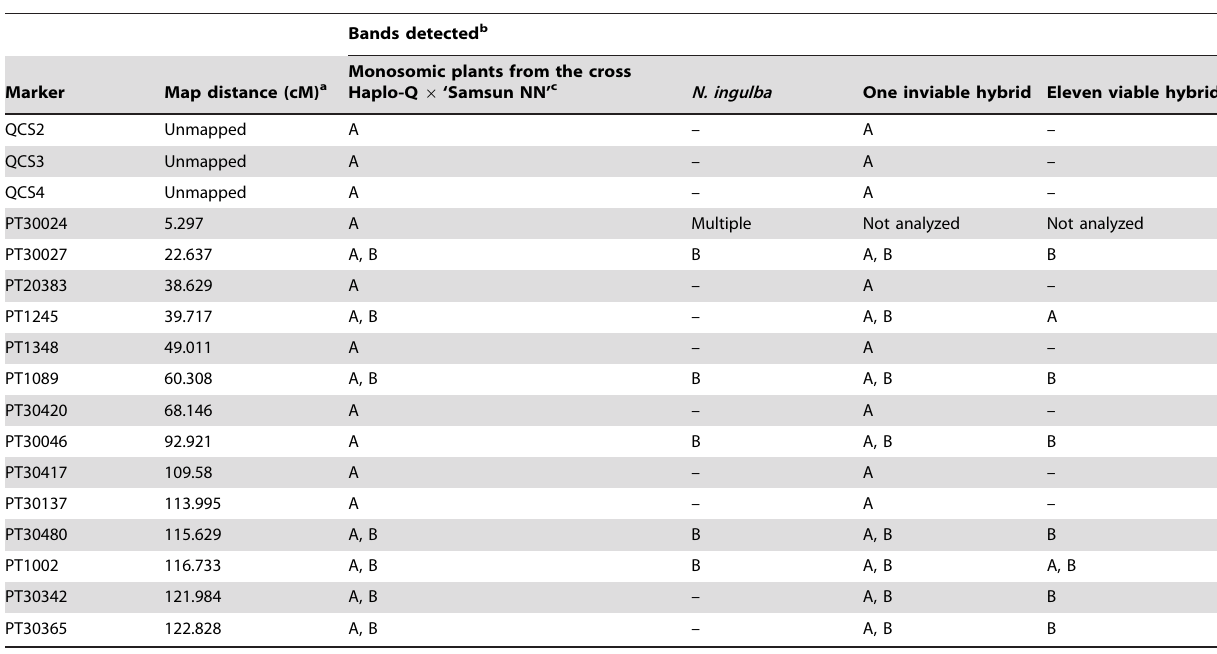
Table 4. Analysis of SSR markers on linkage group 11 and Q-chromosome-specific STS markers in hybrids from the cross (Haplo-Q 6 ‘Samsun NN’) 6 N. ingulba